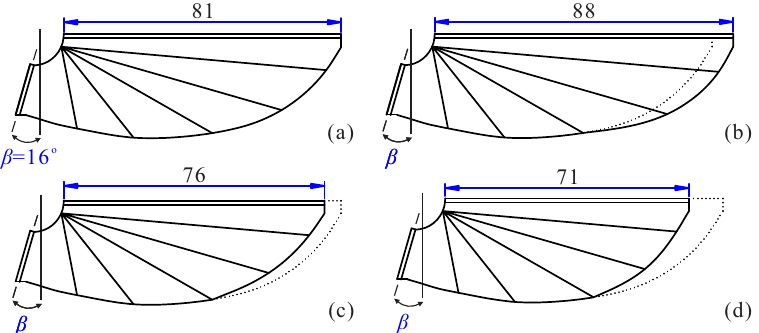
Figure 4. Wings of various sizes, ( a ) 81 mm (nominal), ( b ) 88 mm, ( c ) 76 mm, ( d ) 71 mm. The nominal wing is represented in dotted lines.